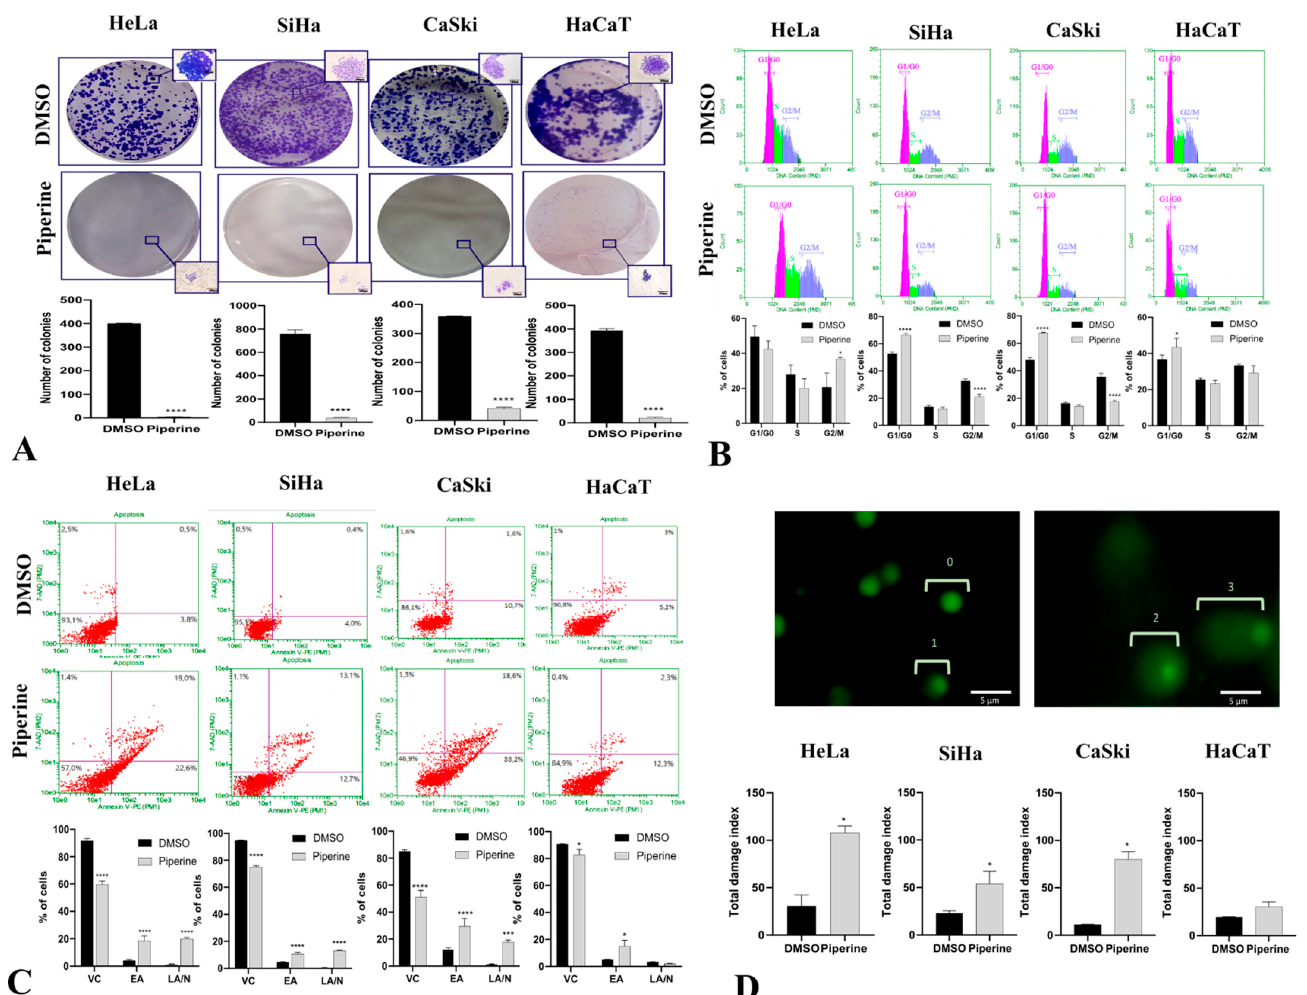
Figure 2. Piperine inhibits colony formation, impairs cell cycle progression, and induces apoptosis by DNA fragmentation. ( A ) Photograph of colony formation and number of cells per colony in SiHa, HeLa, CaSki, and HaCaT lines after 14 days of treatment compared with control (DMSO) and with piperine [150 µ M]. ( B ) Cell cycle analysis in SiHa, HeLa, CaSki, and HaCaT lines after treatment with control (DMSO) and piperine [150 µ M]. ( C ) Representative plots of apoptotic cell death assessed by annexin V-PE and 7-AAD fluorescence in flow cytometry, where annexin V-PE (-) and 7-AAD (-) represents viable cells (VCs), annexin V-PE (+) and 7-AAD (-) represents early apoptosis (EA), and annexin V-PE (+) and 7-AAD (+) represents late apoptosis (LA) or necrosis (N). ( D ) Fluorescence photomicrographs of CaSki cell nuclei with different types of damage assessed by the comet assay: 0 = no apparent damage; 1 = damage 1, with one times the nucleus size; (2) damage 2, with two times the size of the core; and (3) damage 3, with two or more times the size of the core. The graphs represent the damage index in SiHa, HeLa, CaSki, and HaCaT cells after treatment with control (DMSO) and piperine [150 µ M], * vs. control p < 0.05, ** vs. control, p < 0.01, *** vs. control, p < 0.001, **** vs. control, p < 0.0001.